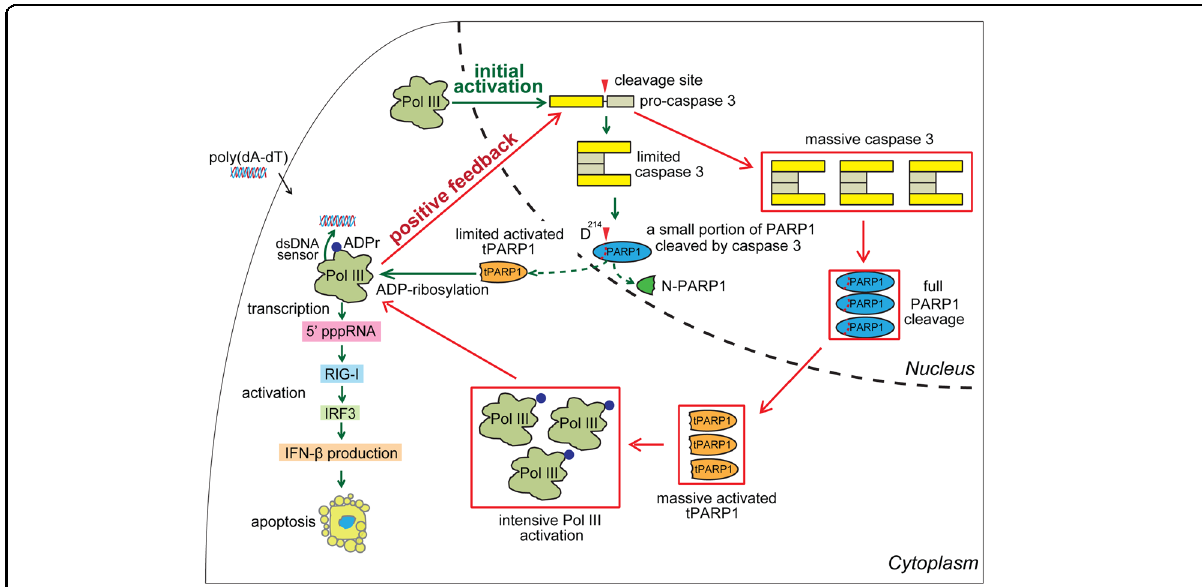
Fig. 8 A model of tPARP1-mediated RNA Pol III ADP-ribosylation forms a positive feedback loop to facilitate apoptosis. Pol III mediates the activation of caspase 3 during the early stage of apoptosis. The early activation of caspase 3 digests a portion of PARP1. Cleaved PARP1 relocates from nucleus to cytoplasm to catalyze ADP-ribosylation on Pol III in cytoplasm, which in turn activates Pol III and RIG-I-dependent apoptotic pathways. ADP-ribosylated Pol III induces a positive feedback loop to further activate caspase 3 and PARP1 cleavage. Eventually, this positive feedback loop accelerates apoptosis. The green lines represent the initial activation of caspase 3, limited cleavage of PARP1, and early-phase activation of the RIG-I pathway. The red lines represent the positive feedback loop via ADP-ribosylation of Pol III, full activation of caspase 3, and the RIG-I pathway to accelerate